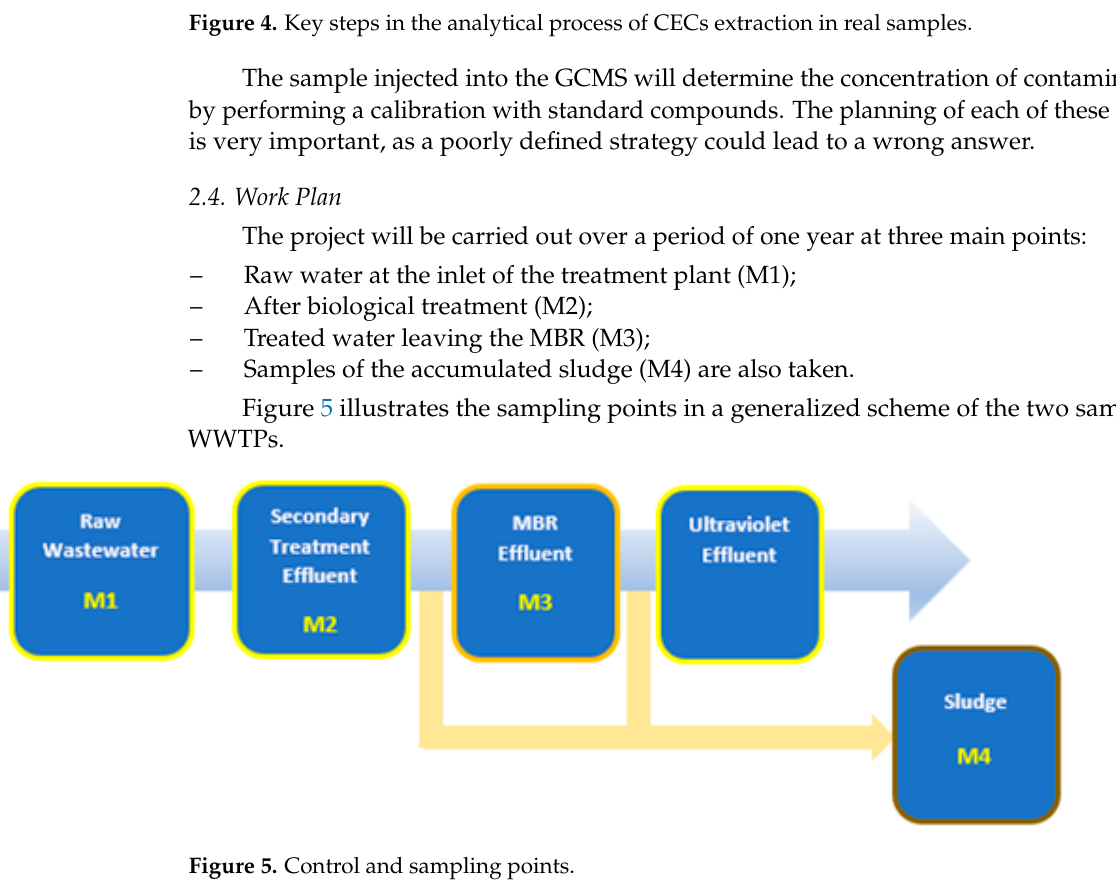
Figure 4. Key steps in the analytical process of CECs extraction in real samples.